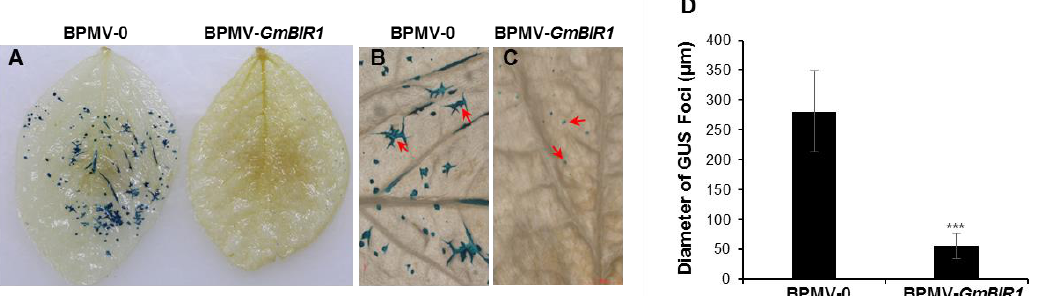
Figure 3. Silencing GmBIR1 enhances the resistance of soybean plants to SMV. At 18 dpi with BPMV-0 or BPMV- GmBIR1 , SMV-N-GUS was biolistically delivered onto the detached leaves of silenced and non-silenced plants. At 5 dpi with SMV-N-GUS, the replication and movement of SMV-N-GUS in the biolistically inoculated leaves was detected by GUS staining. The GUS foci were counted and measured. ( A ) The distribution of SMV-N-GUS foci on the leaves of BPMV-0 and BPMV- GmBIR1 plants. ( B , C ) Infection foci of SMV-N-GUS on the leaves of BPMV-0 and BPMV- GmBIR1 plants. Bar = 2000 μm. ( D ) Comparison of the diameters of SMV-N-GUS foci on the leaves of BPMV-0 and BPMV- GmBIR1 plants. Error bars represent SD of the diameters of at least 30 GUS foci measured on each of three independent leaves (at least 90 foci). Asterisks indicate a significant difference from the control (***, p < 0.001, Student’s t test). This experiment was repeated 3 times with similar results.